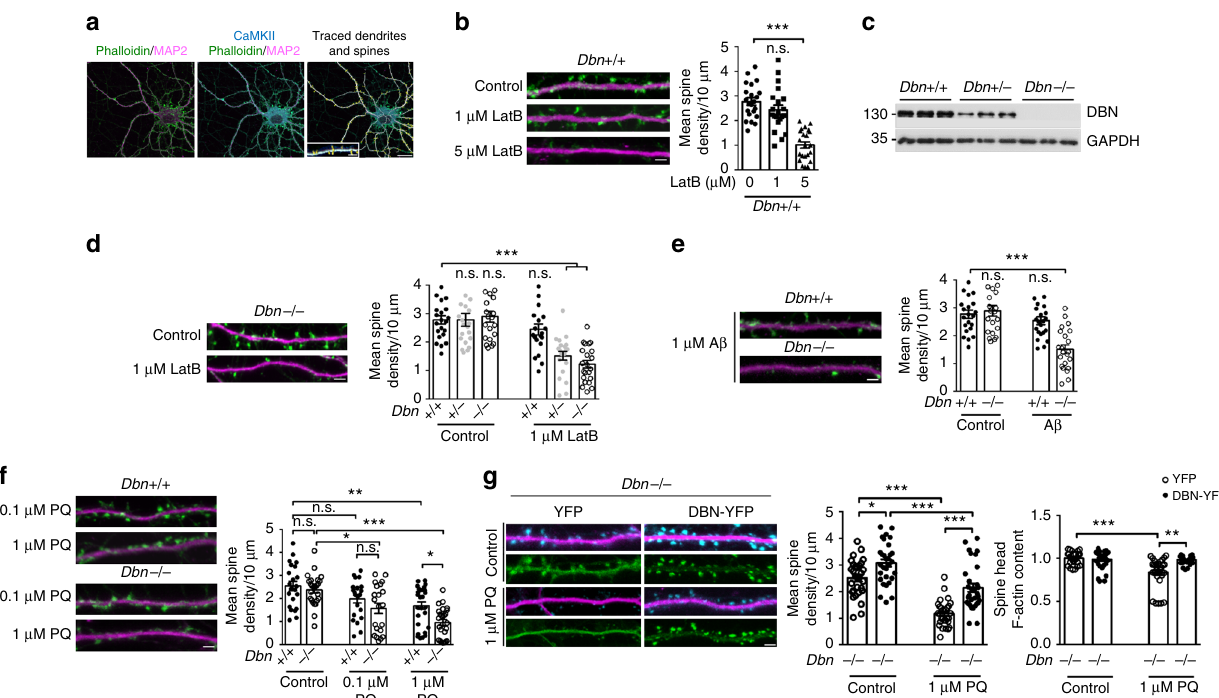
Fig. 1 Increased vulnerability of dendritic spines in DBN-depleted neurons. a Spine density analysis using an automated detection method. Left: WT neurons labelled for dendrites (MAP2, magenta) and dendritic spines (Phalloidin, green). Middle: spines labelled with F-actin (green) and CaMKII (blue) and MAP2 (magenta). Right: detection of the entire dendritic tree (white) and the dendritic spines (yellow) by the Imaris software using MAP2 and Phalloidin labelling. Sub-threshold signals from the underlying dendritic network were ignored (insert). Scale bar: 5 µ m; scale bar in insert: 3 µ m. b Spine density analysis of WT neurons ( Dbn + / + ) treated with latrunculin B (LatB) for 2h. Left: representative image of a dendrite. Scale bar: 3 µ m. Right: mean spine density/10 µ m±SEM. N = 3. LatB 0 µ M: n = 22, LatB 1 µ M: n = 21, LatB 5 µ M: n = 22. c DBN protein levels in adult mouse brain lysates of wild-type ( + / + ), heterozygote ( + / − ) or knockout ( − / − ) Dbn brains. Molecular weight protein ladder is in kilodaltons. d Spine density analysis of Dbn + / + , Dbn + / − or Dbn − / − neurons in the absence (control) or presence of 1 µ M LatB. Left: representative image of a Dbn − / − dendrite. Right: mean spine density/10 µ m±SEM. N = 3. Control, Dbn + / + : n = 22, neurons in the presence of 1 µ M of oligomeric A β 1 – 42 for 24h. Left: representative image of a Dbn − / − and a Dbn + / + dendrite in the presence of A β 1 – 42 . Right: mean spine density/10 µ m±SEM. N = 3. Control, Dbn + / + : n = 22, Dbn − / − : n = 21. A β 1 – 42 , Dbn + / + : n = 22, Dbn − / − : n = 22. f Spine density analysis